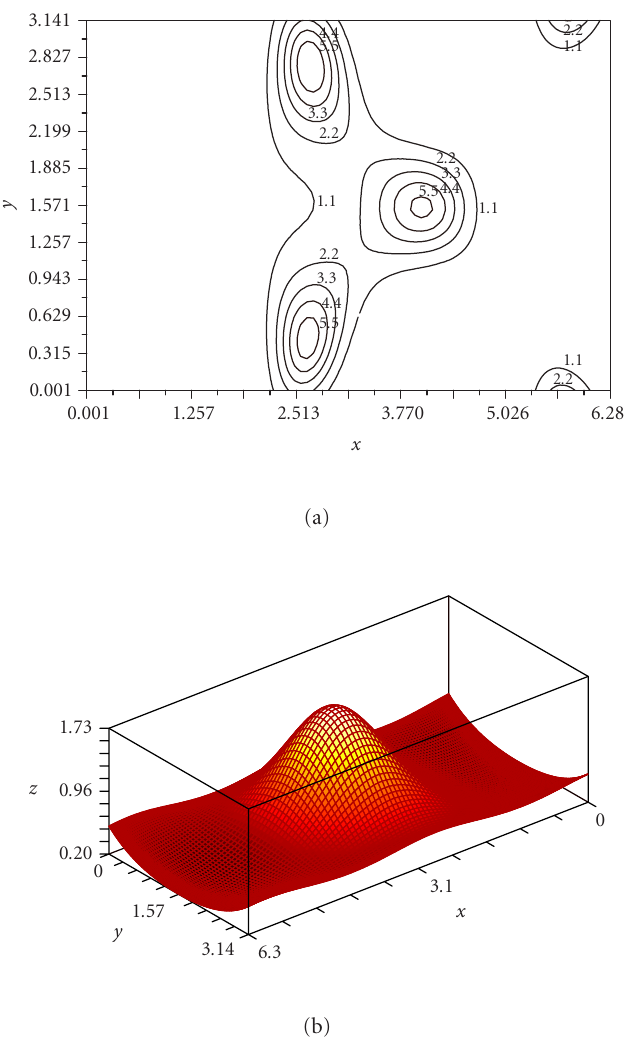
Figure 6.3. (a) Contour plot of the solution obtained by algorithm (4.36) for three Dirac measures with µ = 0 . 5. (b) Solution obtained for three Dirac measures with µ =